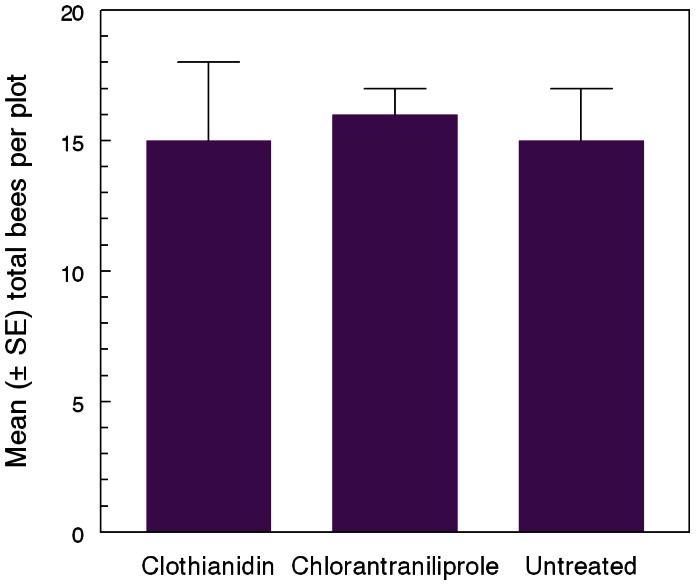
Non-avoidance of treated turf by bees.Bumble bees and honey bees did not discriminate between weedy lawn turf with or without non-irrigated insecticide residues (F
2, 8 = 0.02, P = 0.98). Plots were treated at label rate with residues left on the surface (not watered in) and a walk-through count of foragers on the intermixed white clover was taken on seven successive days. Data shown are mean (+ SE) totals of both types of bees. Means for bumble bees were 6.4±1.1; 6.6±0.9, 5.8±1.2 (F
2, 8 = 0.16, P = 0.85); means for honey bees were 8.8±1.5, 9.0±0.7, 9.4±0.5 (F
2, 8 = 0.10, P = 0.90) for clothianidin-, chlorantraniliprole-, and non-treated plots, respectively.